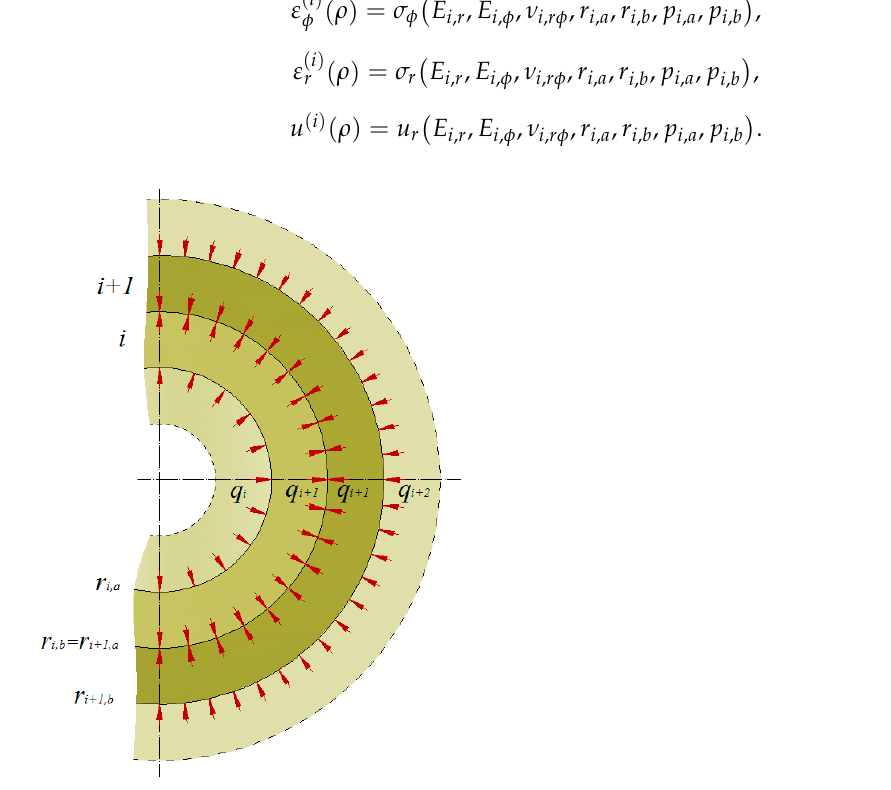
Figure 2. Model of a multi-layer pipe established for the calculations, where r —radius, i —layer, q —inter-layer pressure.